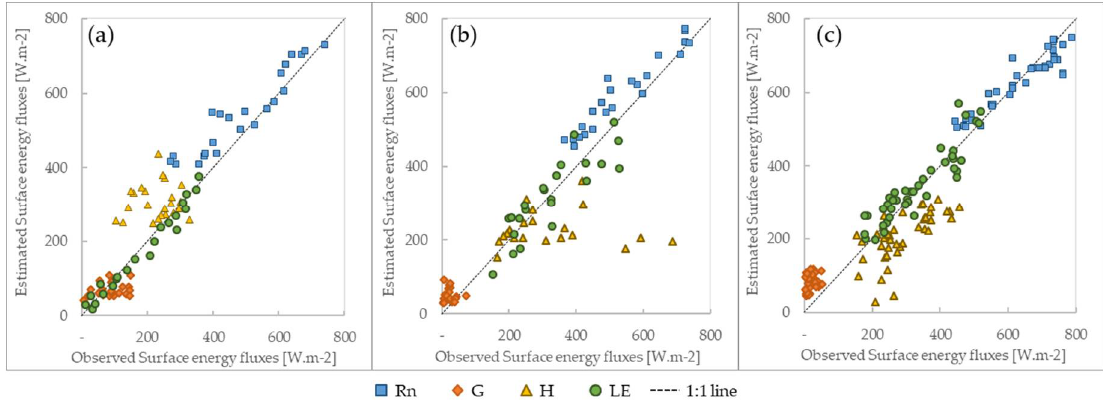
Figure 4. Comparison at the time of satellite overpass between estimated and observed energy balance values of net radiation (Rn), soil heat flux (G), sensible heat flux (H), and latent heat flux (LE) for ( a ) USR (sugarcane), ( b ) PDG (woody savanna), and ( c ) RECOR ( sensu-stricto savanna) experimental sites. The dotted line represents the 1:1 relation.